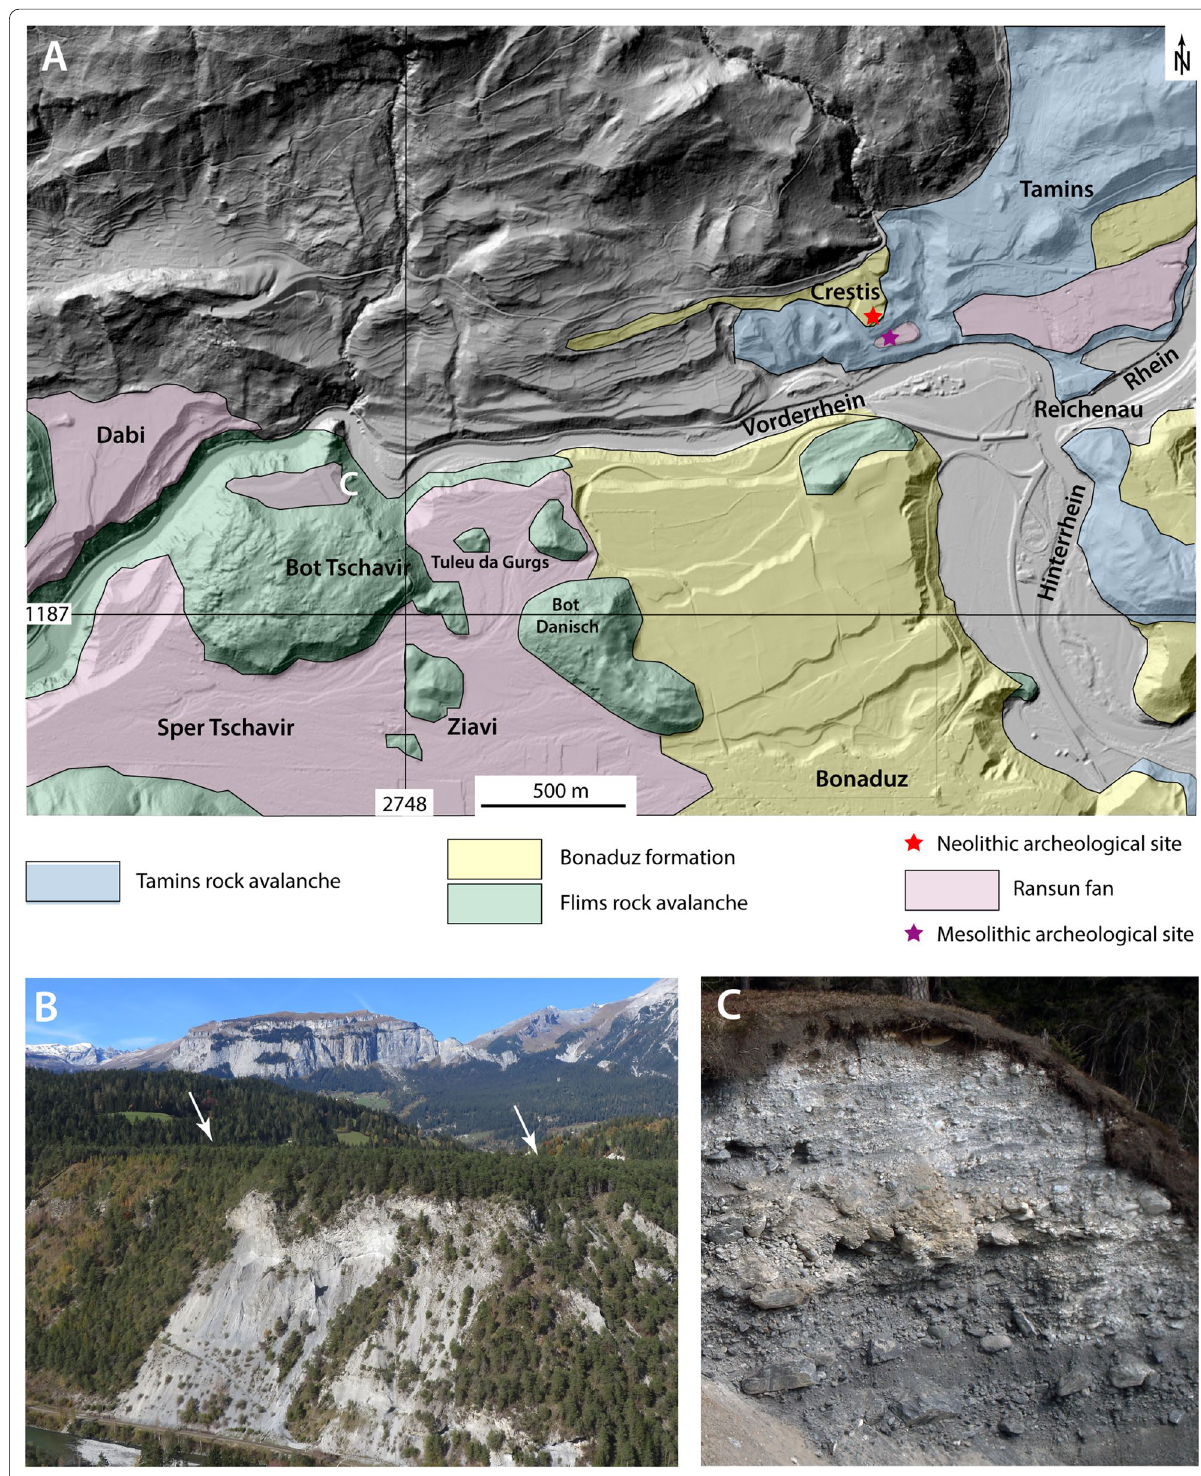
Fig. 17 The Ransun fan: outburst of Lake Ilanz. A Digital elevation model of the Ransun fan. West of Bonaduz the Ransun fan overlies the Bonaduz Formation but incised it just north of Bonaduz. At Crestis the Ransun fan has incised the Bonaduz Formation more deeply. B View of the Ransun plain (white arrows) looking west. C Ransun fan deposits at Plaun dils Stiarls displaying a homogeneous composition of gray (Quinten) limestone clasts. Photos A.